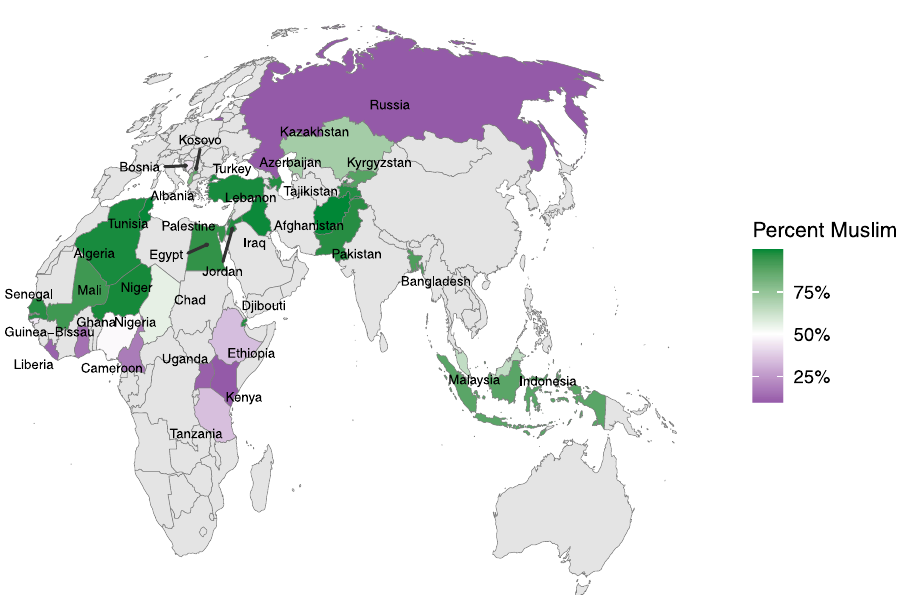
Fig 1. Map showing countries included in the analysis by percent Muslim. Mollweide projection used to preserve area proportions.